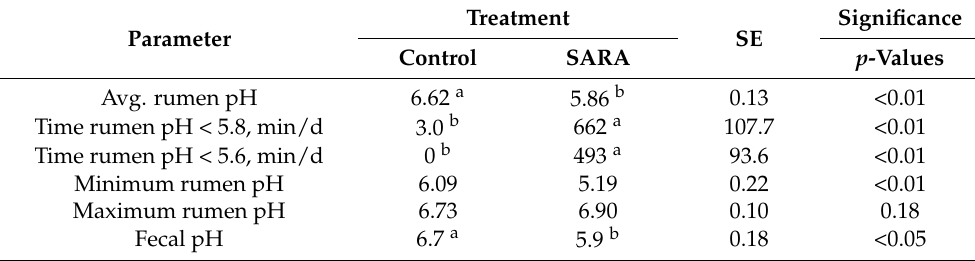
Table 2. Rumen and fecal pH of cows on the control and the SARA-challenge diet. Parameter